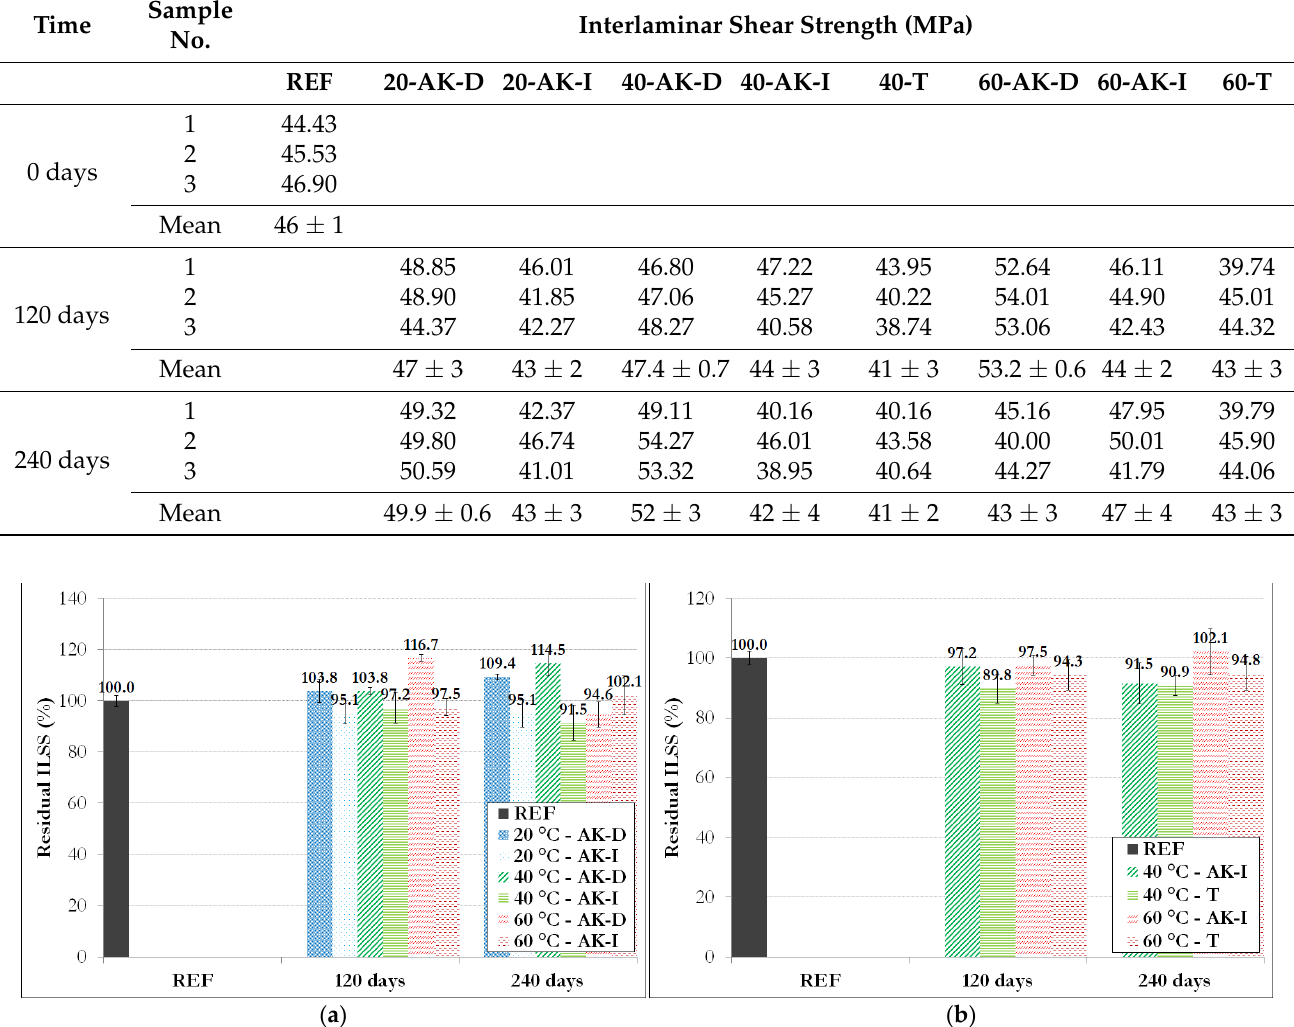
Figure 17. Residual interlaminar shear strength of GFRP rebars after aging in different environments: ( a ) AK-D versus AK-I and ( b ) AK-I versus T.